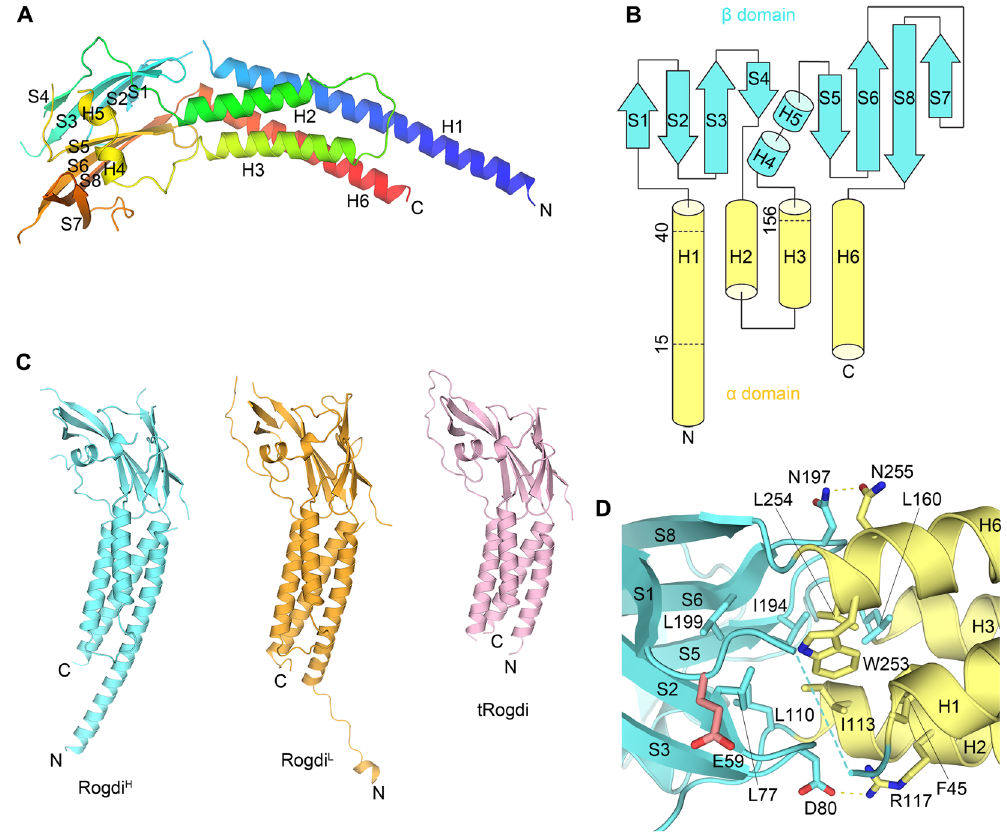
Figure 2. Crystal Structure of Rogdi. ( A ) Ribbon diagram showing the structure of full-length Rogdi. The protein is composed of two distinct α and β domains. The protein chain is colored blue to red from the N- to C-terminus. ( B ) Topological diagram showing the secondary structural elements and domain organization of human Rogdi. Helices and strands are depicted by cylinders and arrows, respectively. ( C ) Overall structure of full-length Rogdi (Rogdi H = cyan, Rogdi L = orange) and tRogdi (pink) in the same orientation for comparative purposes. ( D ) Close-up view showing residues that contribute to the tight association at the interface between the β (cyan) and β (yellow) domains. Oxygen and nitrogen atoms are colored red and blue, respectively. Yellow dotted lines indicate intermolecular hydrogen bonds. The Glu 59 residue known as a polymorphism (E59K) in human Rogdi is highlighted in